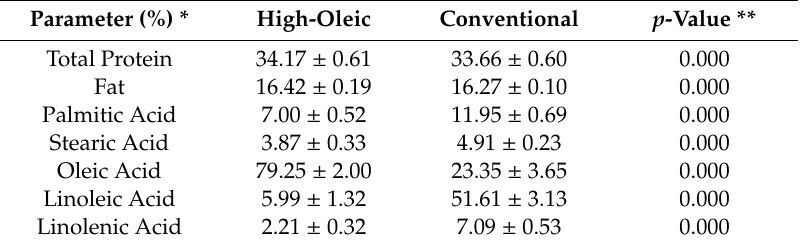
Table 2. Total protein, fat content, and fatty acid composition comparison of high-oleic and conventional soybean samples.